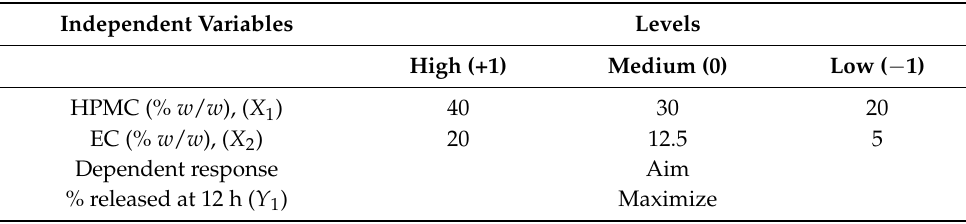
Table 2. Independent factors and response for 3 2 full factorial design. Independent Variables